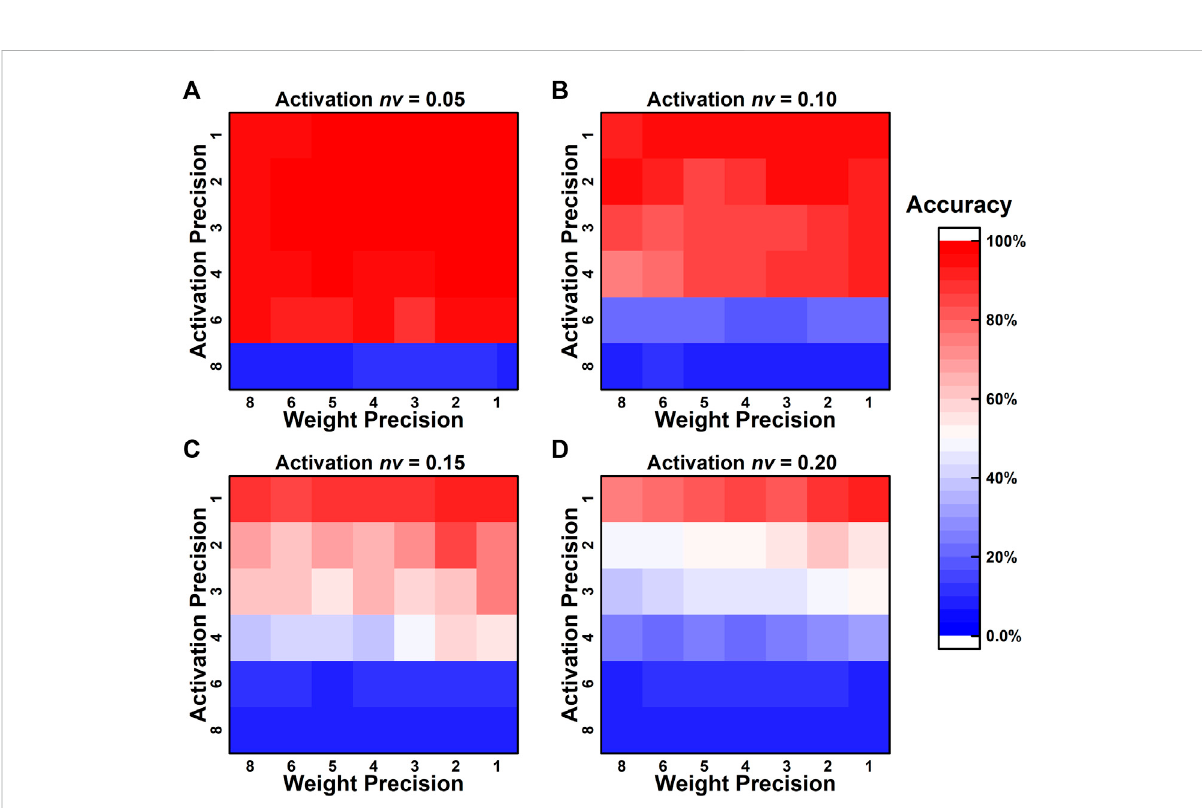
FIGURE 4 The effect of different quantization precisions on network robustness to the activation